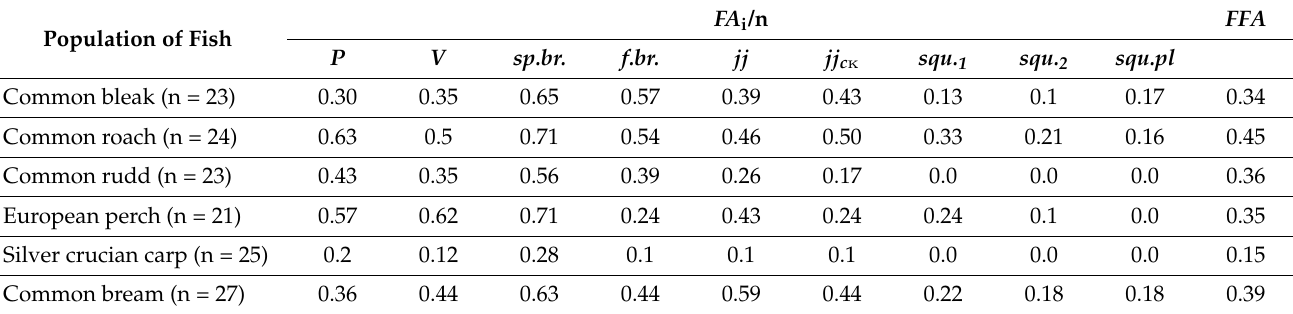
Table 4. The FFA for each studied fish population in the Sluch River at sampling site No. 2 ( p ≤